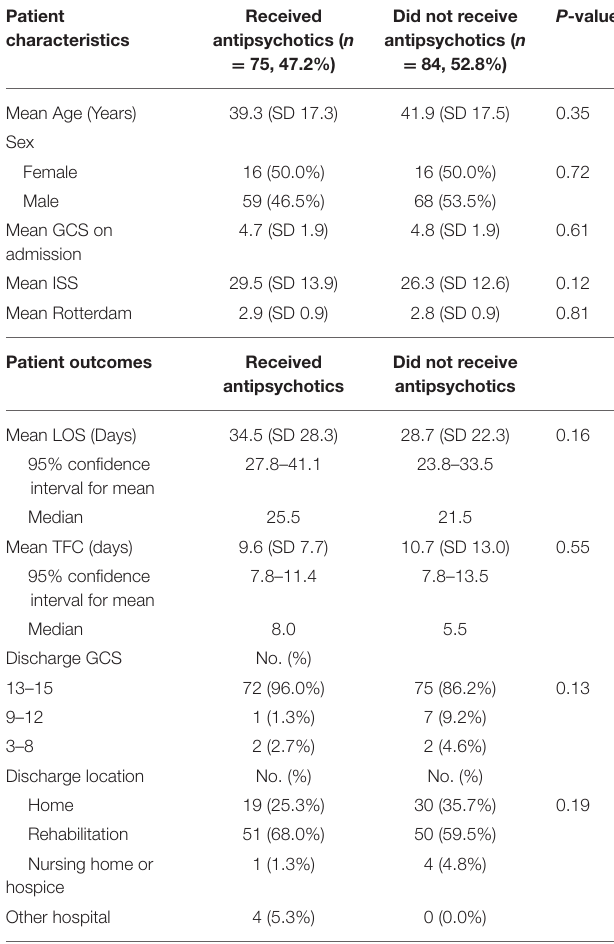
TABLE 3 | Association between agitation onset and command-following, n = 119. Total number of in-hospital agitation